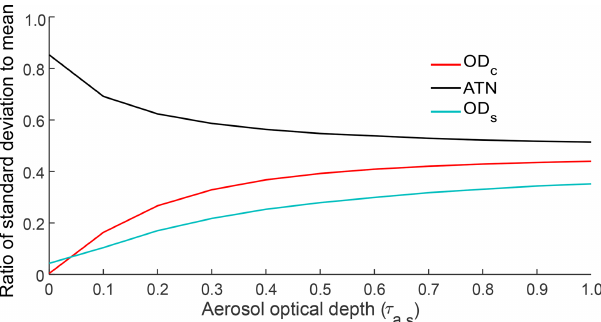
Figure 3. Ratio of standard deviations to means of modeled filter optical depth measures (OD c , ATN and OD s ) averaged over 500 equally spaced SSA points ranging 0.2–0.99, corresponding to each value of aerosol optical depth ( τ a , s ). Blank optics were randomly generated for each sample point from a normal distribution, with mean = 0 . 7 and SD = 0 .